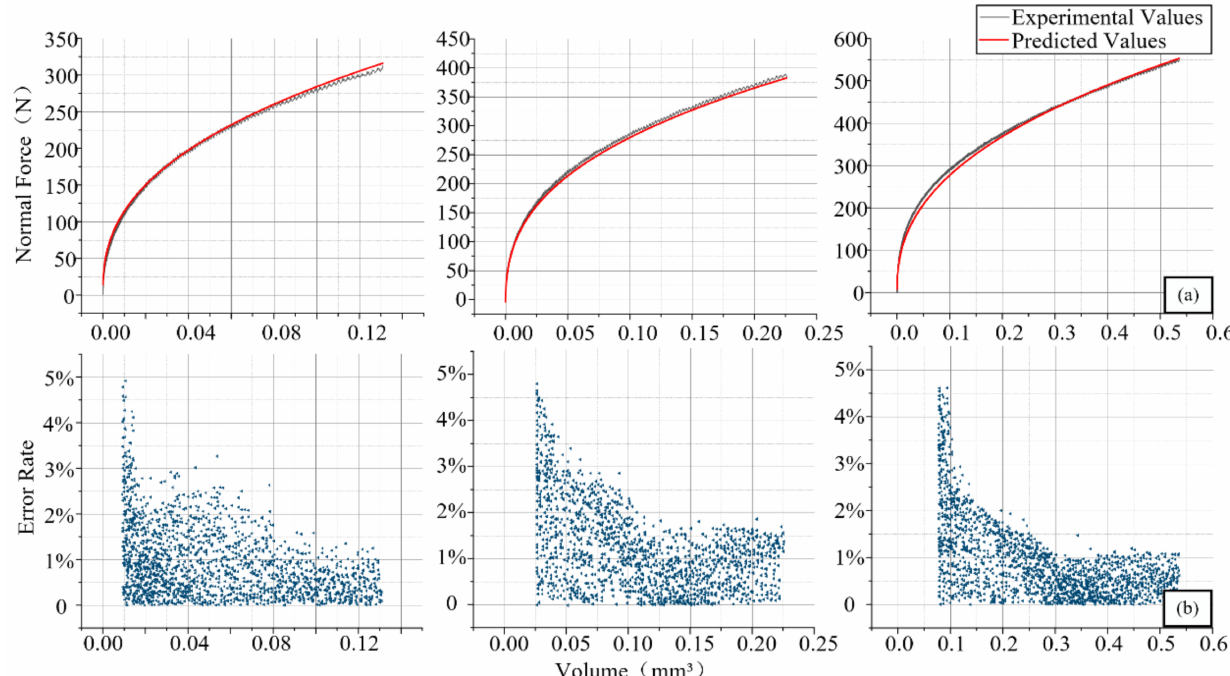
Figure 6. Comparison between experimental value and predicted value of various volumes ( a ); error rate distribution of residual of various volumes ( b